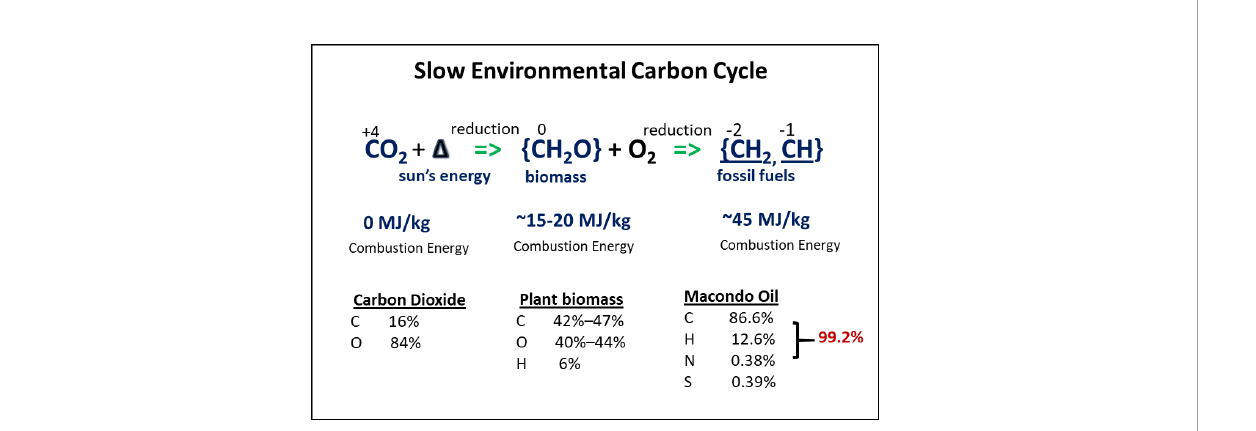
FIGURE 1 An overview of molecular transitions that occur over geological timescales during the Slow Environmental Carbon Cycle. Carbon dioxide in the atmosphere and seawater is converted to living organisms by photosynthesis. The C, H and O ratio content of this biomass is ~CH 2 O. When a small portion of the biomass is preserved and buried in deep reservoirs over many millions of years, this material is converted to a liquid hydrocarbon fl uid with average molecular ratio of CH 1.75 (mostly saturate compounds with a smaller proportion of aromatic compounds) based on C and H percent compositions. The heats of combustion (combustion energy) for typical biomass and crude oils show how much energy is stored in the C and H bonds of these two